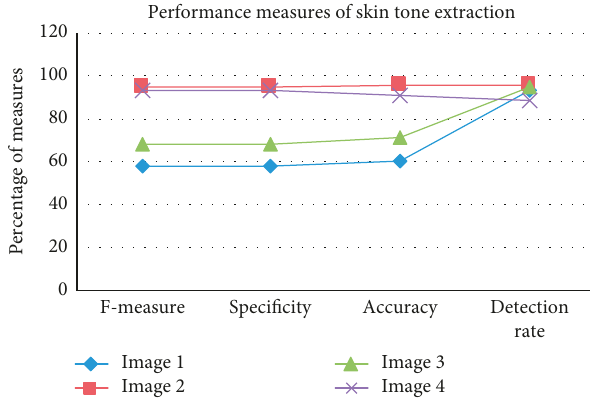
Figure 3: Curve of various